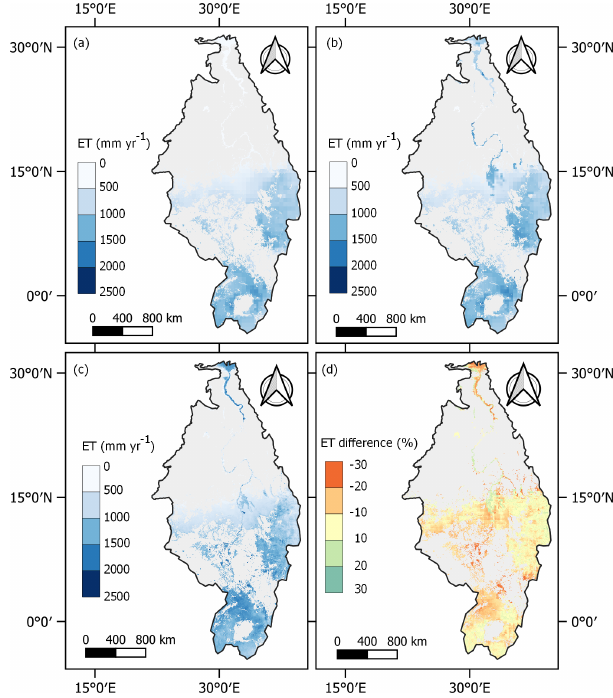
Figure 10. Spatial distribution of agricultural ET. (a) Default SWAT + model ET. (b) Revised SWAT + model ET. (c) WaPOR ET. (d) ET difference (WaPOR ET − revised SWAT + model